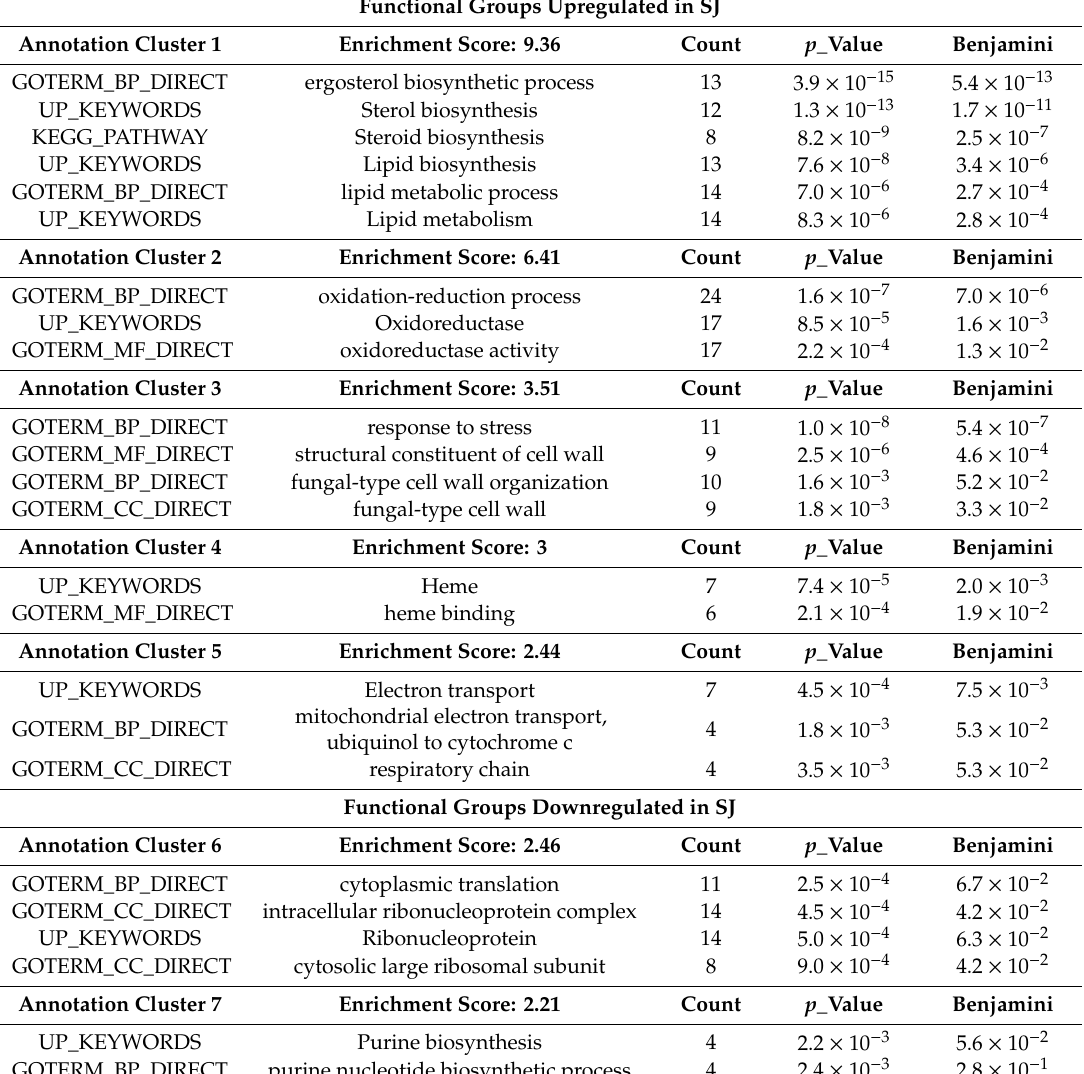
Table 2. Annotation clusters of M25 and EC1118 ORFs showing significant medium and not significant strain e ff